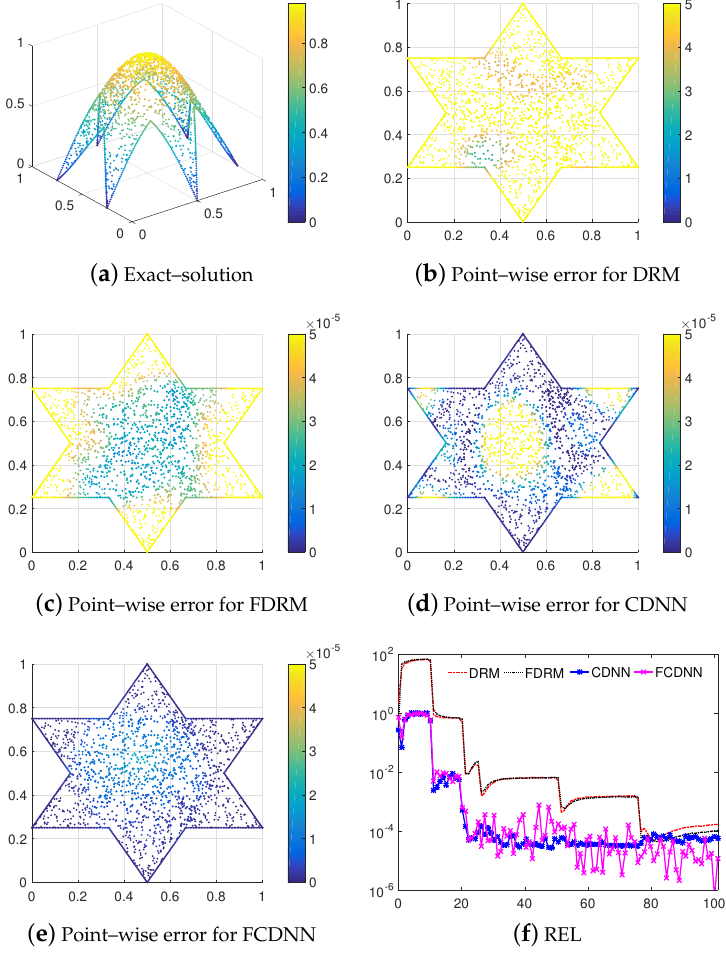
Figure 5. Testing results for Example